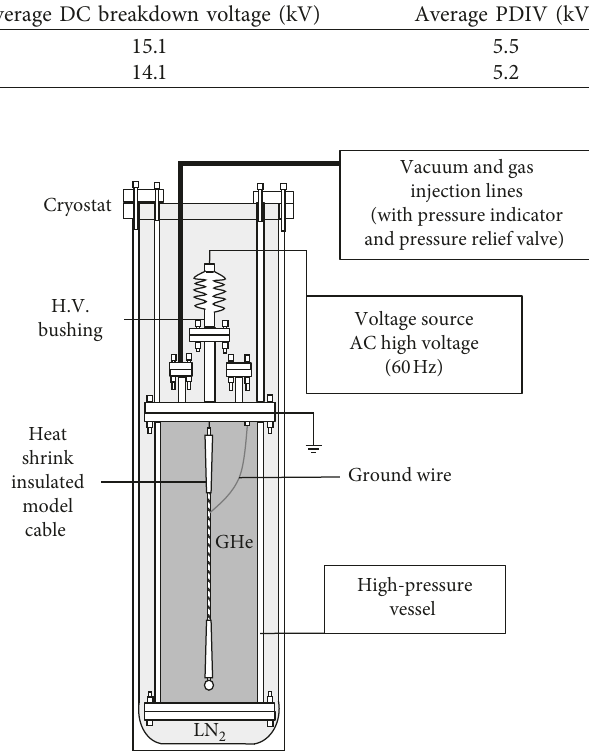
Figure 8: A schematic of the experimental setup used for breakdown voltage measurements on the model cables in 2.0MPa GHe at